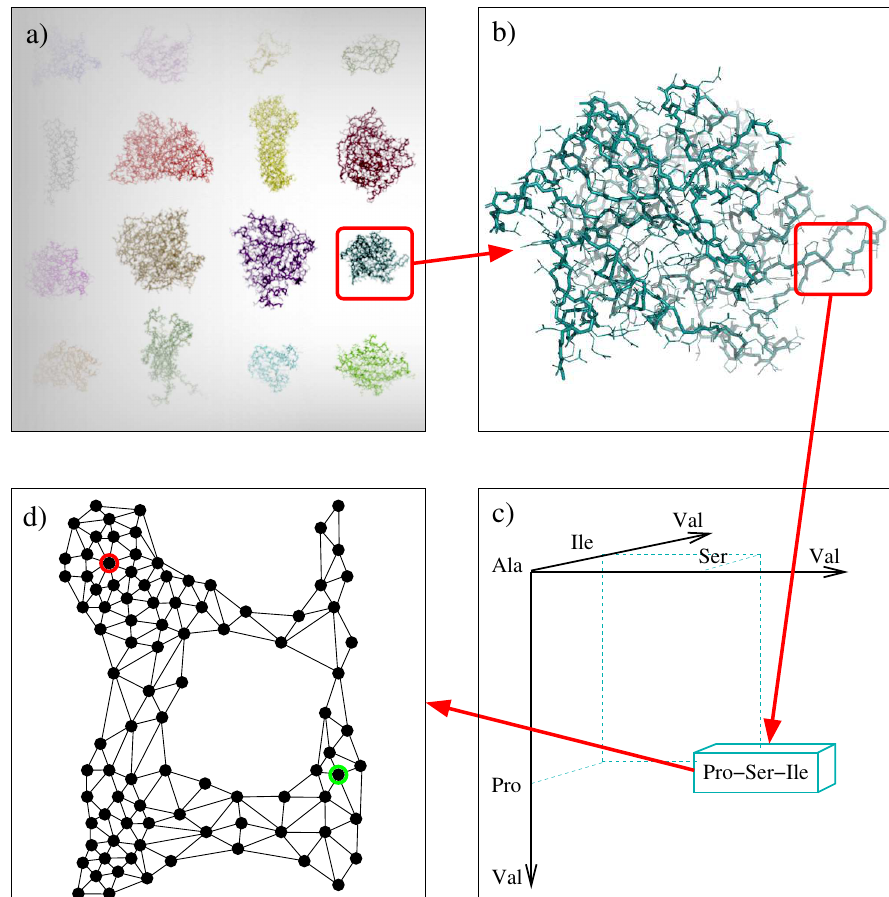
Figure 5. Construction of the tripeptide database: ( a ) A non-redundant set of experimentally-determined protein structures is used as input. ( b ) For each protein, fragments of three consecutive residues (called tripeptides) are analyzed. ( c ) The structural information is stored in a database containing one record for each tripeptide (8000 in total). ( d ) For each tripeptide, the conformations recorded in the database are related with a proximity criterion and structured into an adjacency graph (the figure shows a simplified representation of this graph for tripeptide